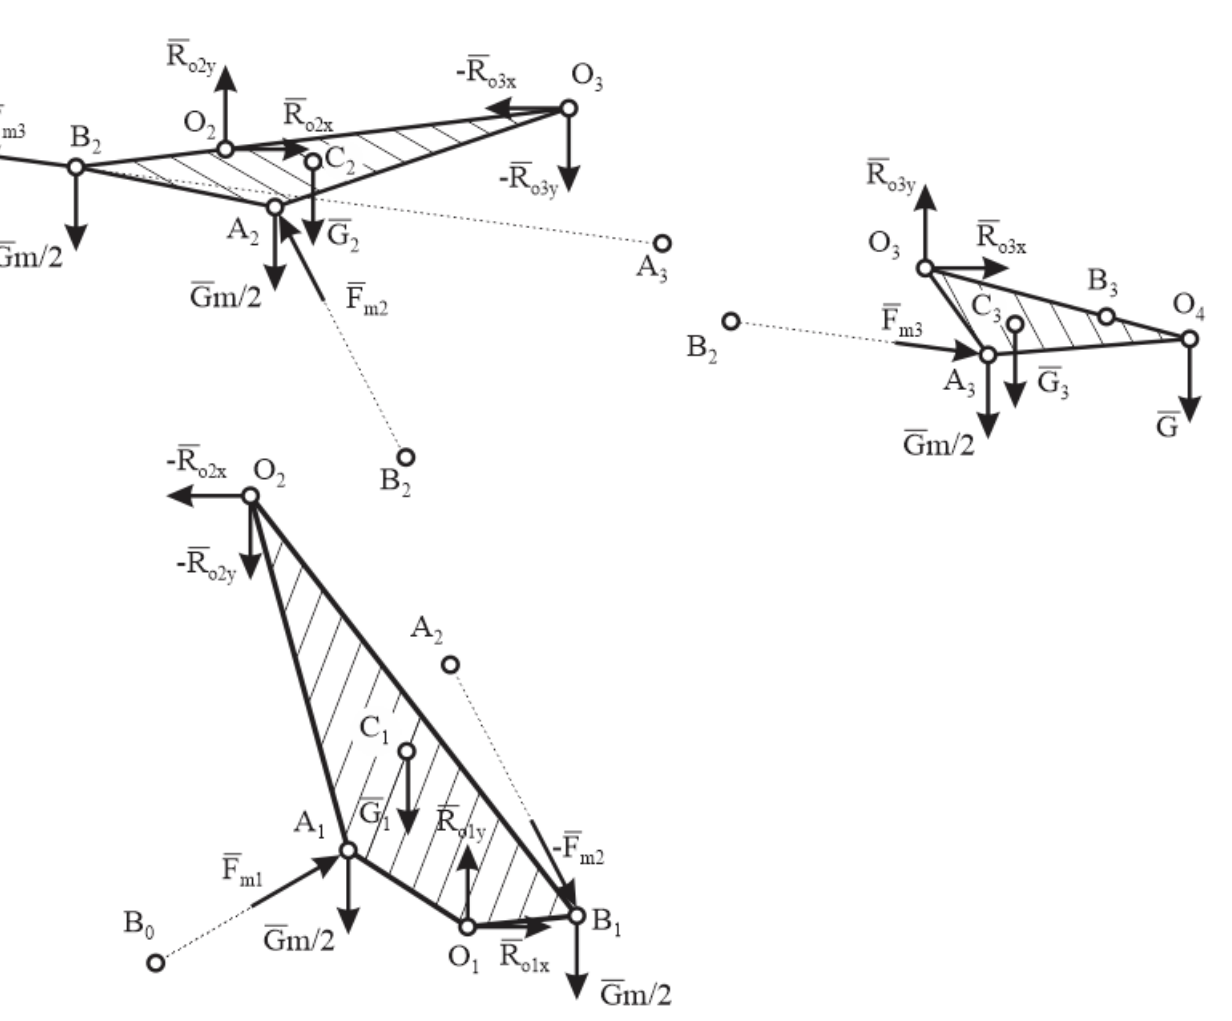
Figure 10. Representation of how the arms of the robot were isolated to perform the analytical cal- culations.